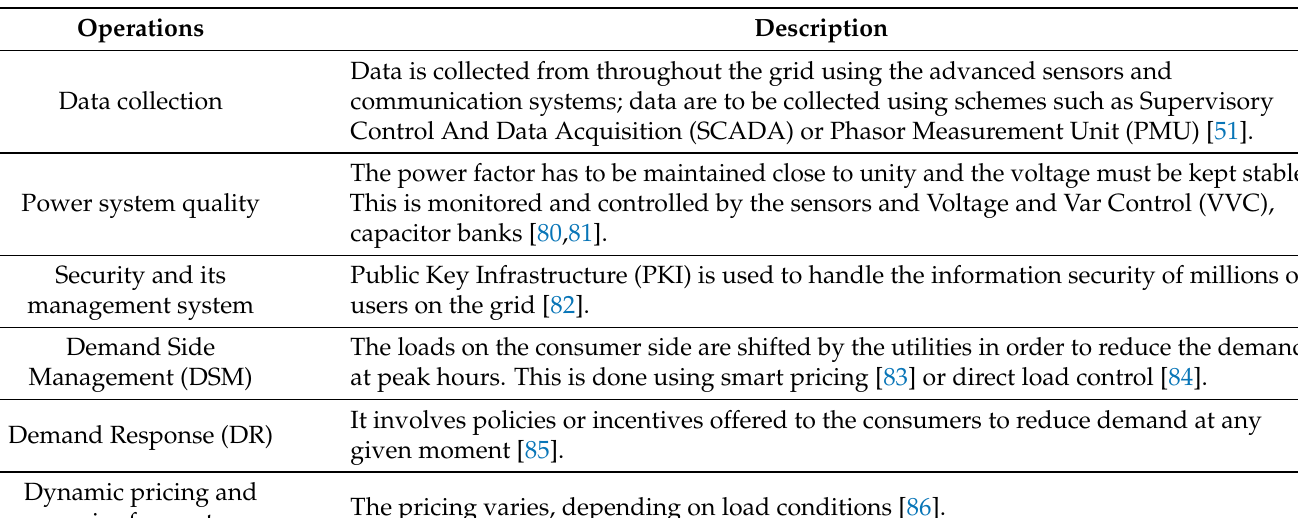
Table 6. Operations of the smart power management